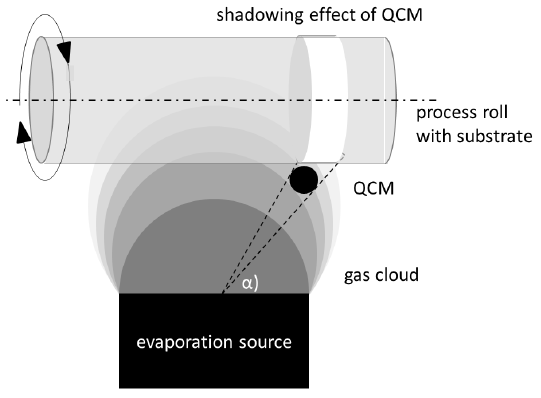
Figure 5. Arrangement of a QCM in the vacuum deposition unit.